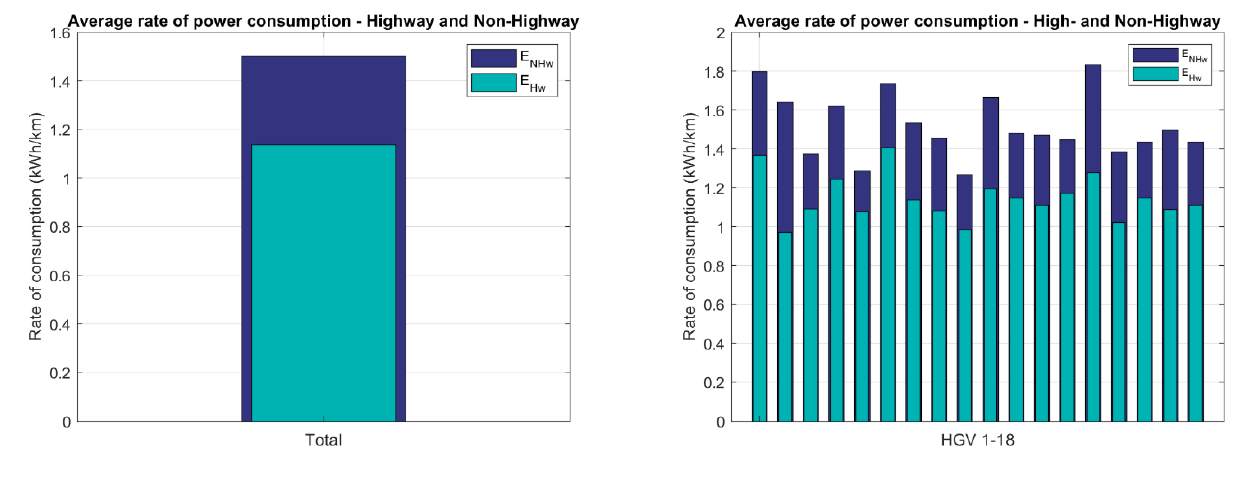
Figure 4. Average consumption of highway and nonhighway routes (own illustration).